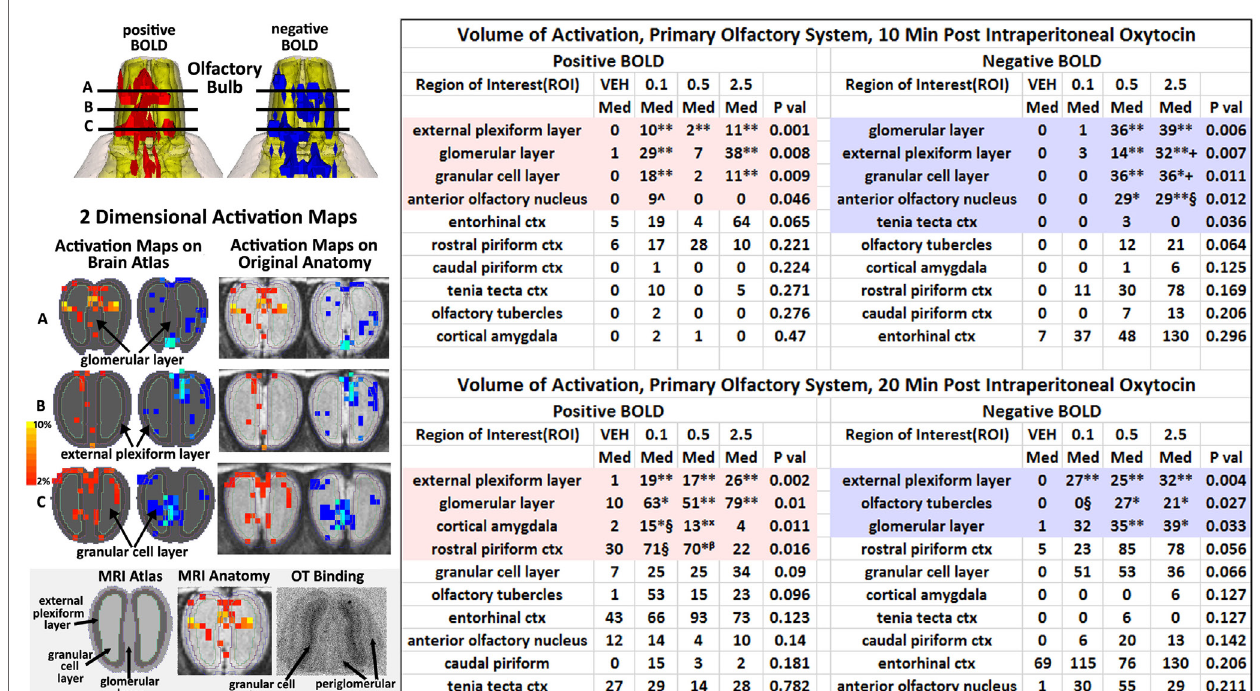
FigUre 5 | intraperitoneal oxytocin and the olfactory bulb . The 3D images in the top left corner are magnifications of the olfactory bulbs shown in Figure 4 . Below on the left are 2D activation maps from the rat brain atlas showing the precise location of the significantly altered positive (red) and negative (blue) voxels following IP OT (2.5 mg). The figures on the right show the localization of the voxels on the original neuroanatomical images. The vertical color strip indicates the percent change in BOLD signal. The lines (A, B, C) through the 3D top images show the approximate position of the axial 2D images below. The middle figure in the bottom panel shows the positive BOLD activation pattern on the original bulb neuroanatomy while the left figure shows the specific layers segmented and annotated as they appear in the rat atlas. The figure to right shows an autoradiogram of approximately the same section depicting OT binding in the granular layer (dark contrast). The tables show the median number of positive and negative for vehicle, 0.1, 0.5, and 2.5 IP OT at 10 and 20 min post IP injection. For the 0.1 mg dose positive BOLD, 10 and 20 min: * P < 0.05 ** P < 0.01 compared to Veh; ^ P < 0.05 compared to 2.5 mg; § P < 0.05 compared to 2.5 mg. For the 0.5 mg dose positive BOLD 10 and 20 min: * < 0.05 ** P < 0.01 compared to Veh; β P < 0.05 compared to 2.5 mg. For the 2.5 mg dose positive BOLD, 10 and 20 min: **